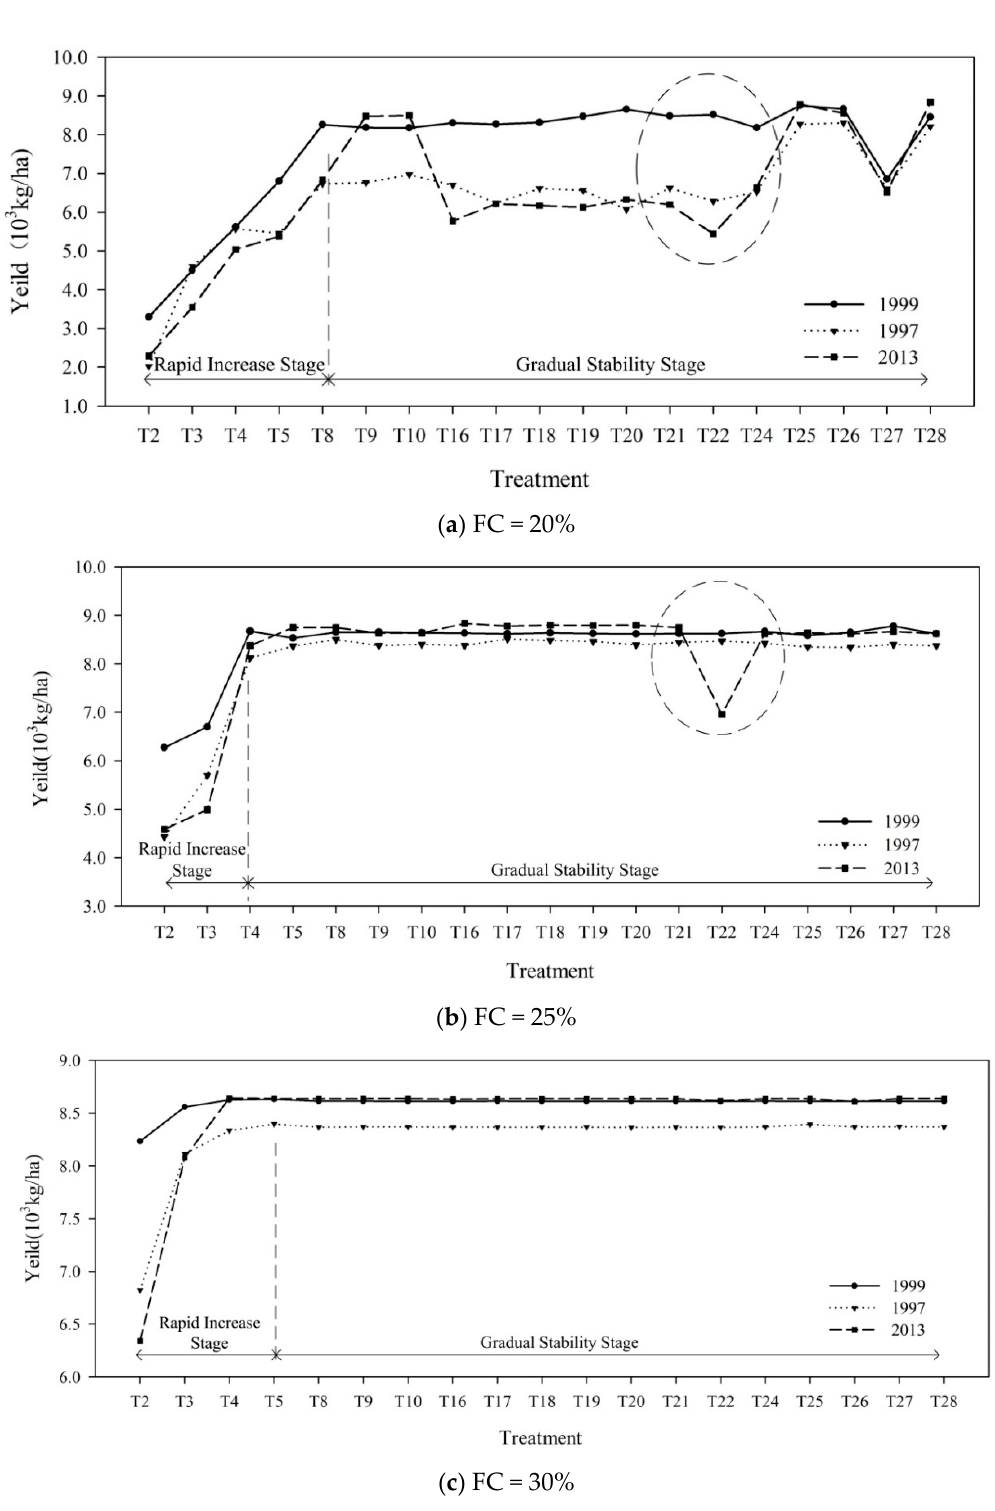
Figure 5. Diagram of the relationship between the irrigation quota and yield under the different treatment conditions. treatment